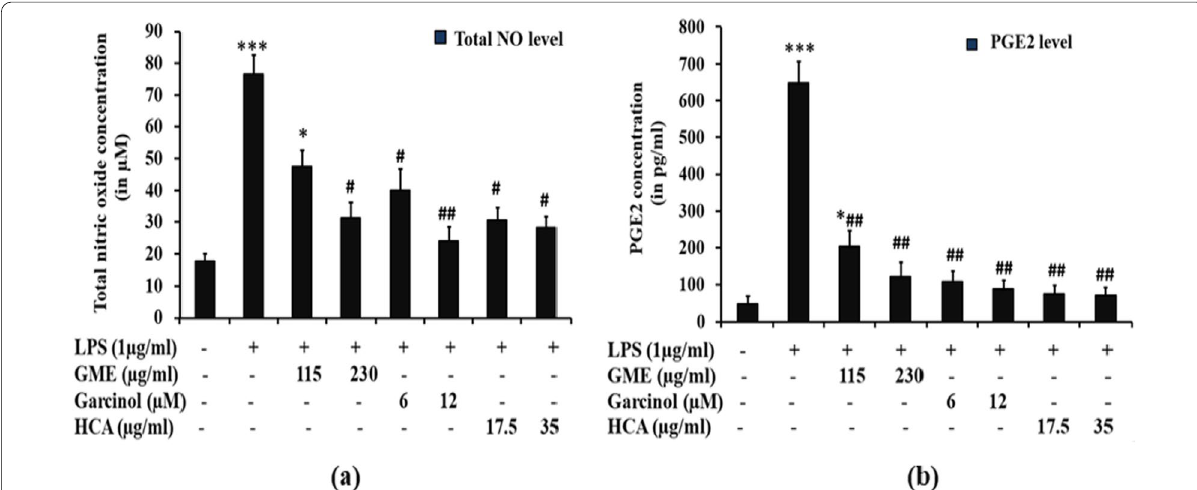
Fig. 7 Effects of GME, Garcinol and HCA on a total nitric oxide (TNO) level and b prostaglandin E2 (PGE2) level in LPS-stimulated RAW264.7 cells . Cells were treated with GME (115 µg/ml and 230 µg/ml); Garcinol (6 µM and 12 µM); HCA (17.5 µg/ml and 35 µg/ml) before LPS (1 μg/ml) stimulation followed by 24-h incubation. The data represented are the mean SEM. * p < 0.05, ** p < 0.01, *** p < 0.001 vs. the control group; # p < 0.05, ± ## p < 0.01, ### p < 0.001 vs. the LPS group